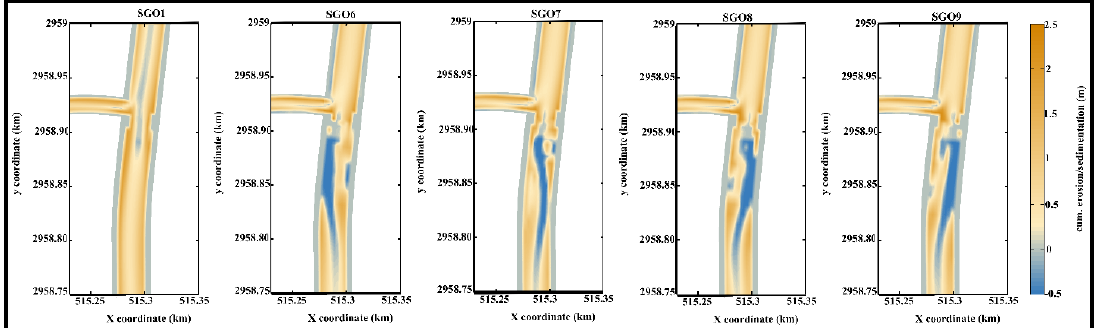
Figure 15. Cumulative erosion/sedimentation by opening one gate compared to the reference case.